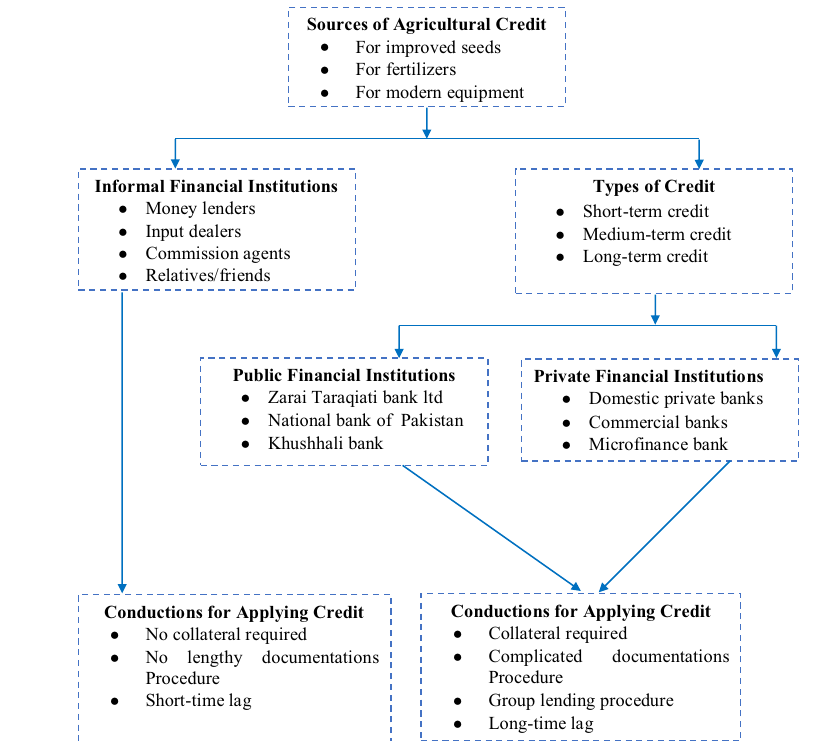
Figure 1. Ruralfinancialservices providedbyformaland informal sources